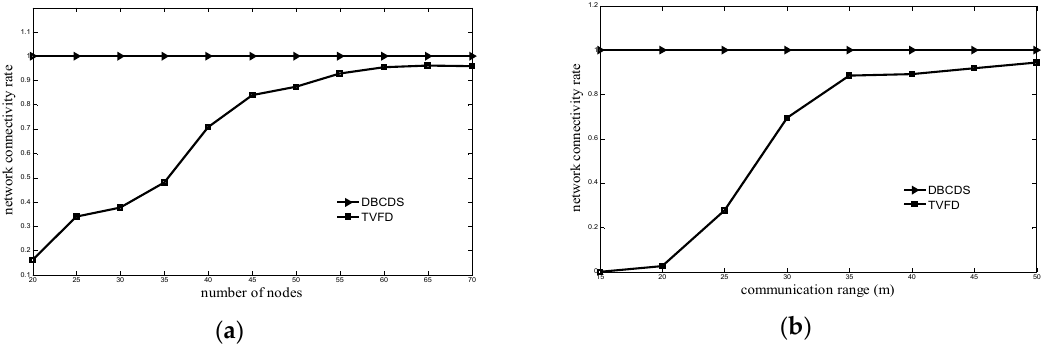
Figure 5. Comparison of network connectivity rate: ( a ) Comparison of network connectivity rate when number of nodes varies; ( b ) Comparison of network connectivity rate when communication range varies.